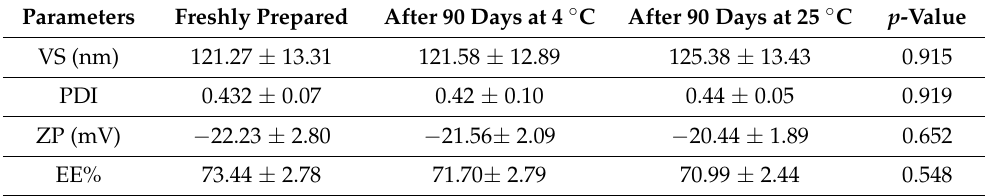
Table 4. Effect of storage on physical stability of N7 a,b .